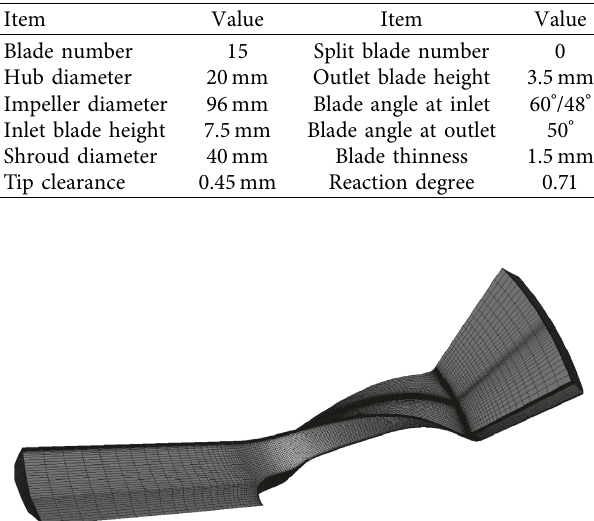
Figure 14: Computational grid of the IET supercritical CO impeller.